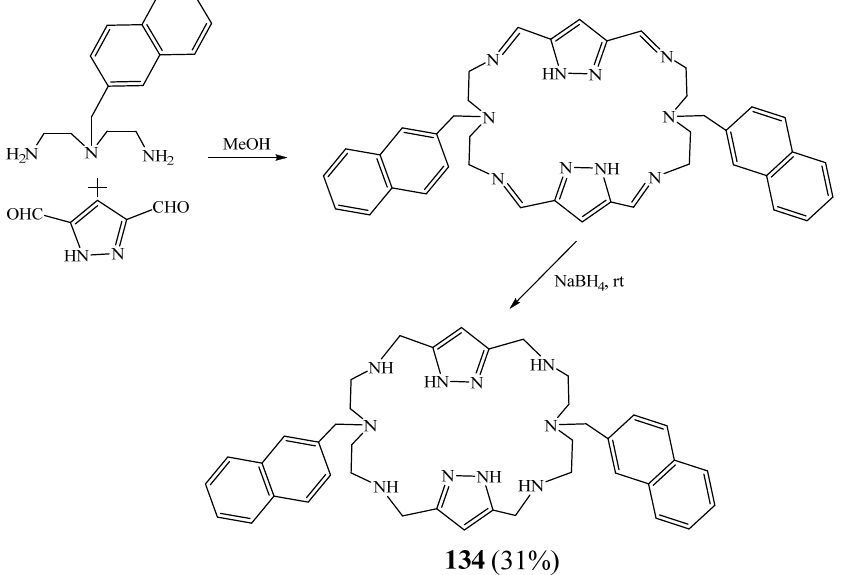
Figure 36. Synthetic pathway of bipyrazolic macrocycle 134. (Reprinted with permission from ref. [58]. Copyright 2010 Royal Society of